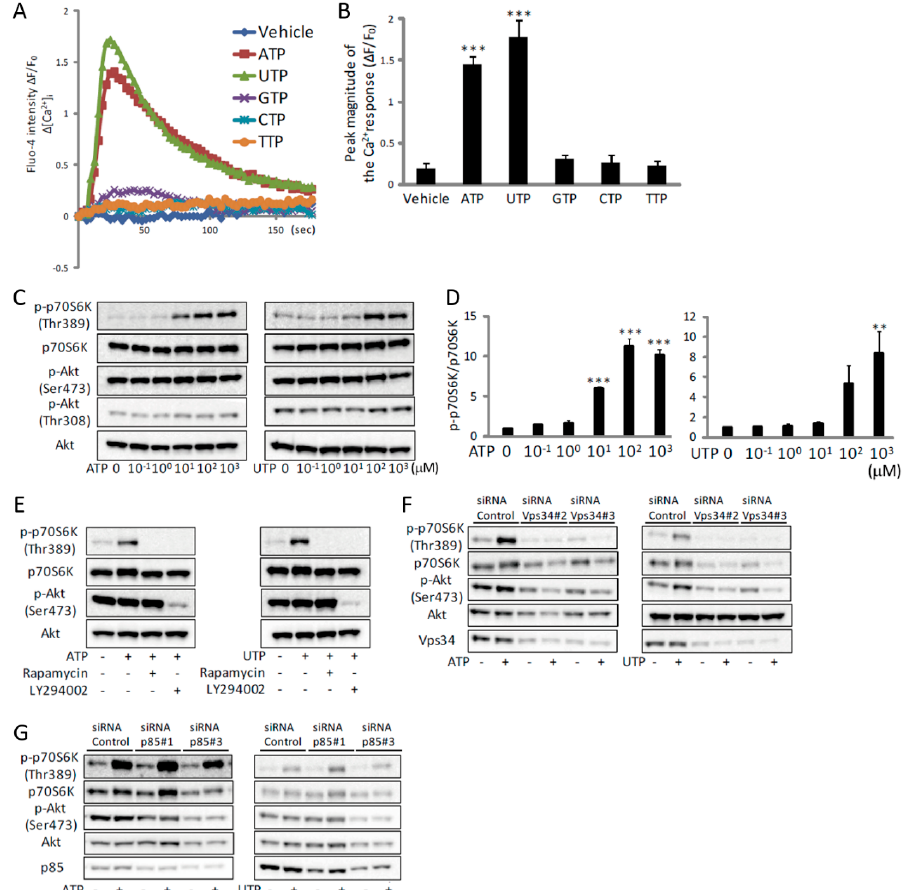
Figure 2. ATP induces an increase in [Ca 2+ ] i and activation of mTOR via Vps34 in C2C12 myotubes.